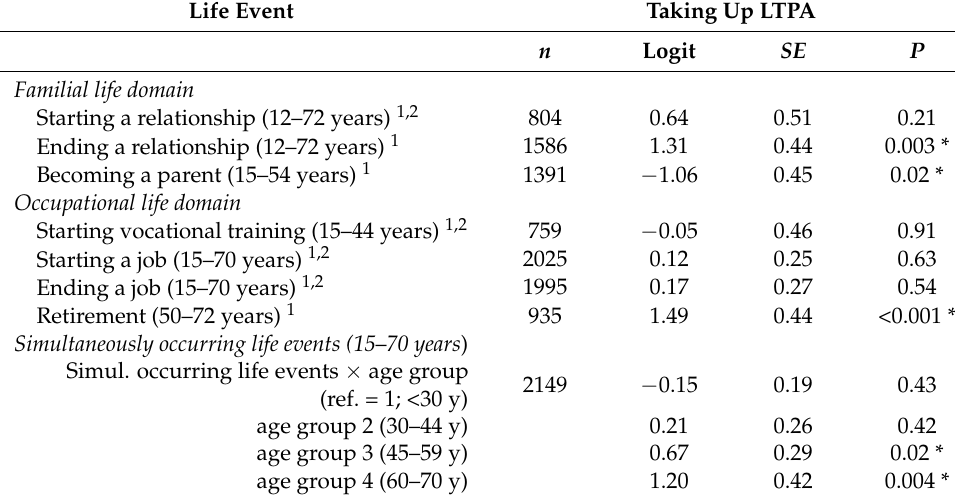
Table 2. Multilevel discrete-time event history analysis with separate calculations for each life event and taking up leisure-time physical activity, controlled for sex, level of education, previous inactivity duration, quotient active years, and age group (for each complete model reported, see Supplementary Materials). Life Event Taking Up LTPA n Logit SE P Familial life